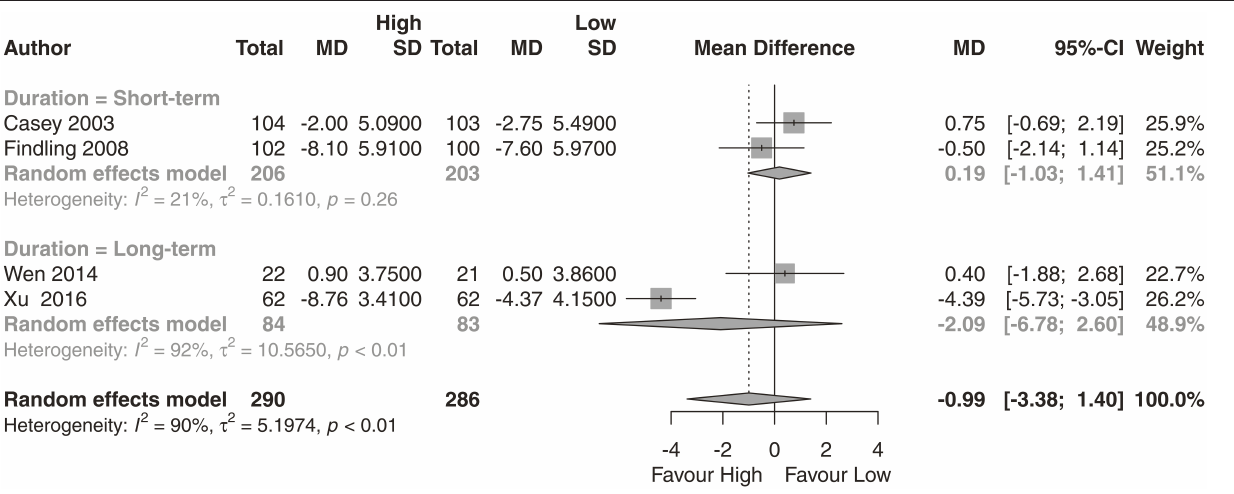
FIGURE 3 | PANSS positive score. High, high-dose strategy; Low, low-dose